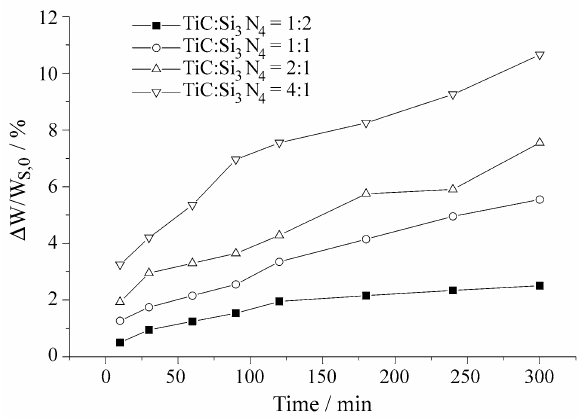
Figure 4. Weight losses of the TiC-Si 3 N 4 mixtures with various ratios of the components during heat treatment at 1500 °C vs. heat treatment time.